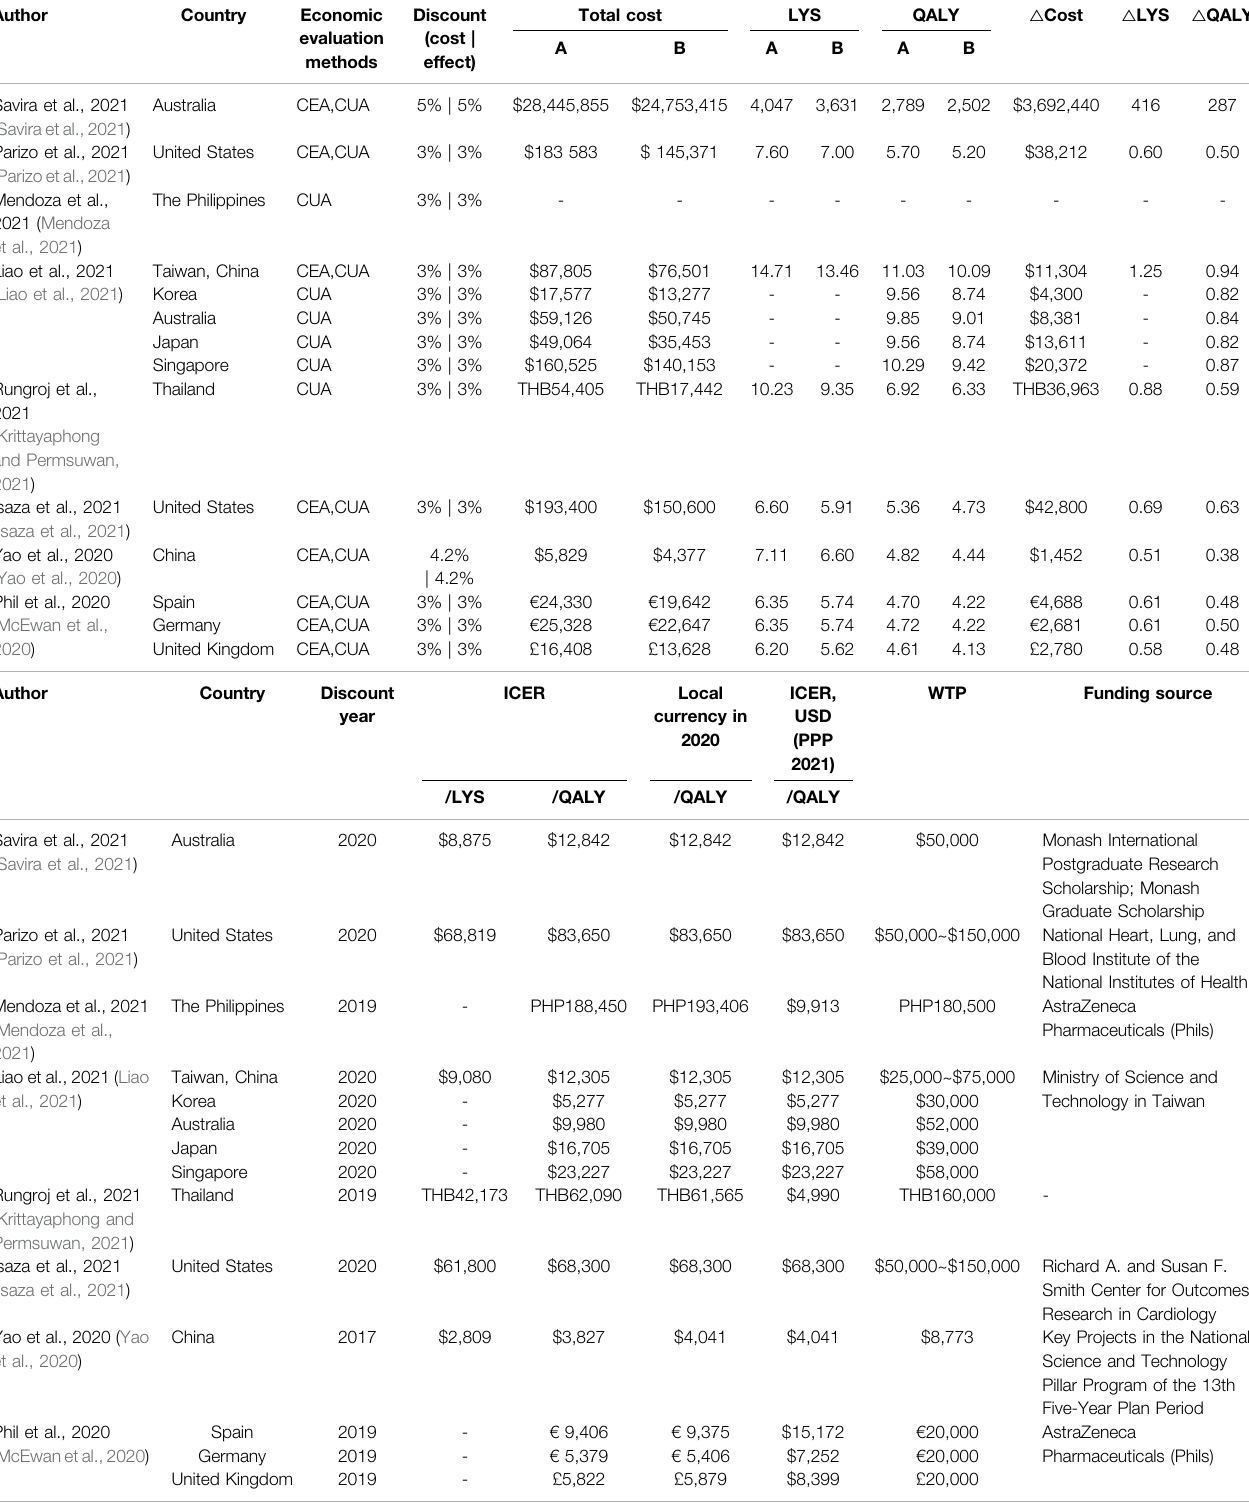
TABLE 2 | Methods and results of included